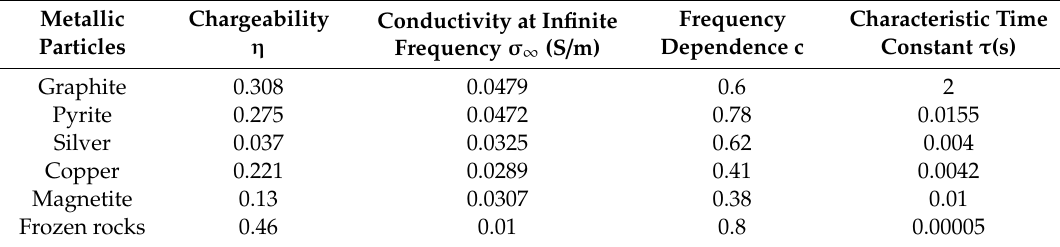
Table 1. Polarization parameters of common metal